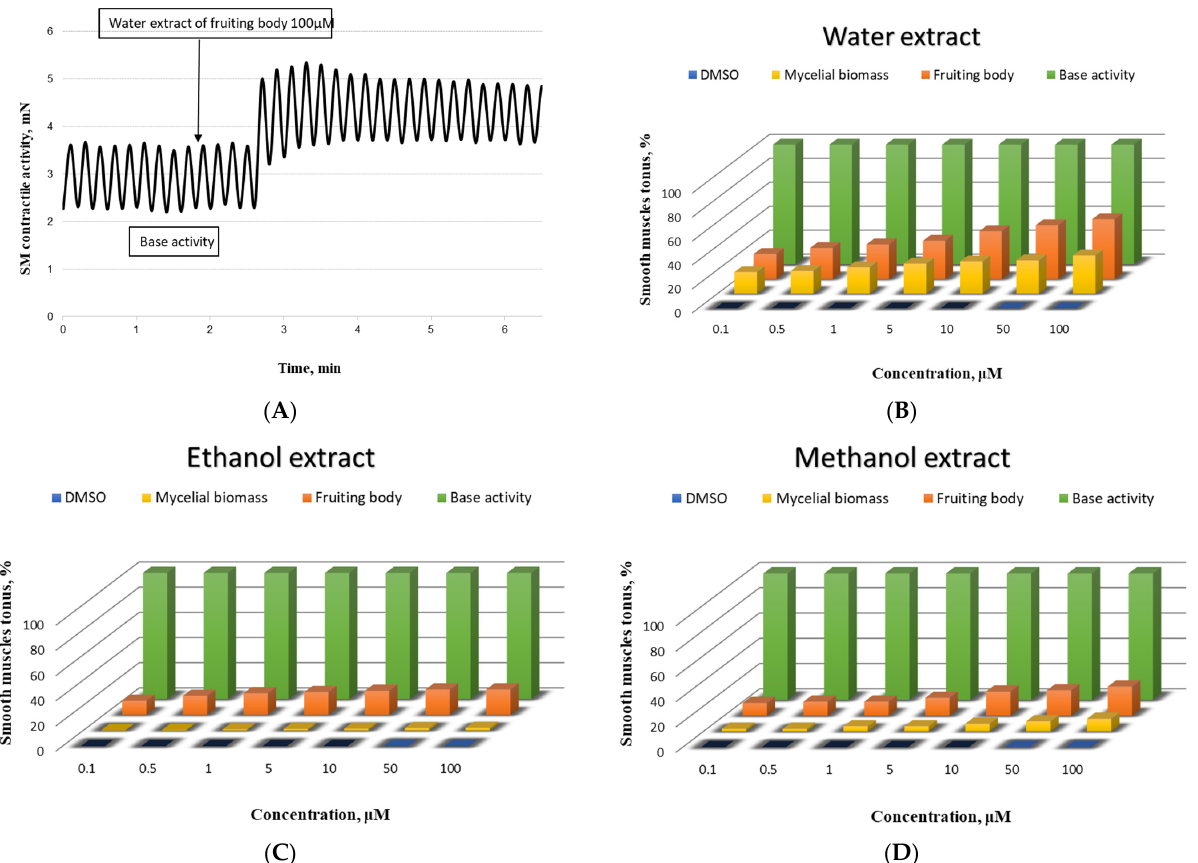
Figure 1. Biological activity of the newly isolated Pleurotus ostreatus strain on the SMPs. ( A )—Representative tracing of gastric SM elicited by 100 μ M of the applied mushroom extract of the fruiting body; concentration-effect dependence of the effect of mushroom sample (water extract—( B ), ethanol extract—( C ), and methanol extract—( D )) on the muscle tonus of SM from the stomach ( n = 9); base activity is taken as 100%.